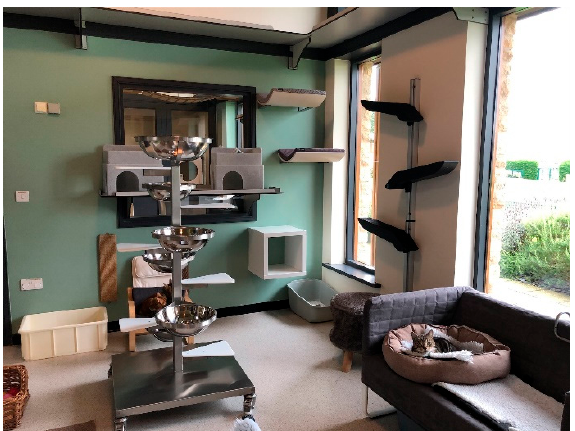
Figure 4. A cat housing room at Waltham showing a stainless steel bowl cat tower and use of walls for enrichment.